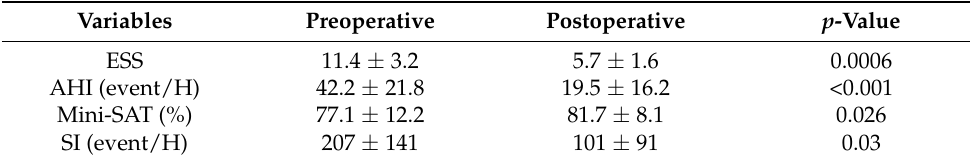
Table 1. Comparison of preoperative and postoperative outcomes for TOTS.